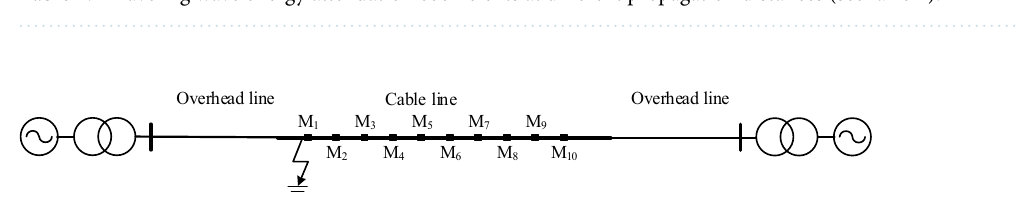
Table 4. Traveling wave energy attenuation coefficients at different propagation distances (scenario 1).